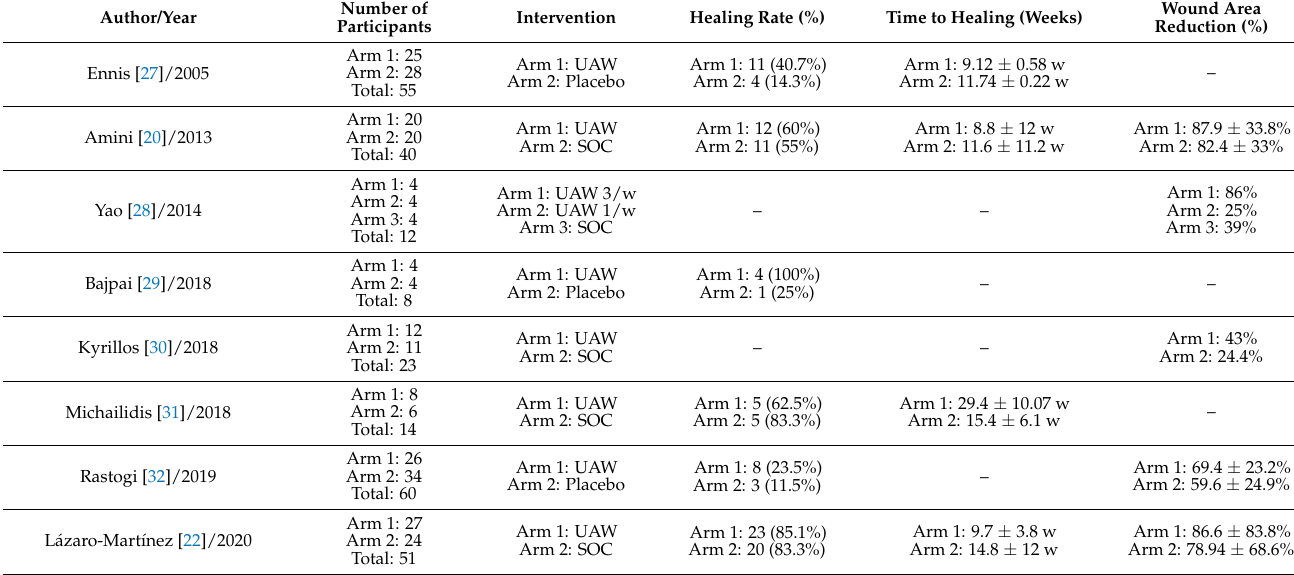
Table 2. Characteristics of the RCTs included in the systematic review.